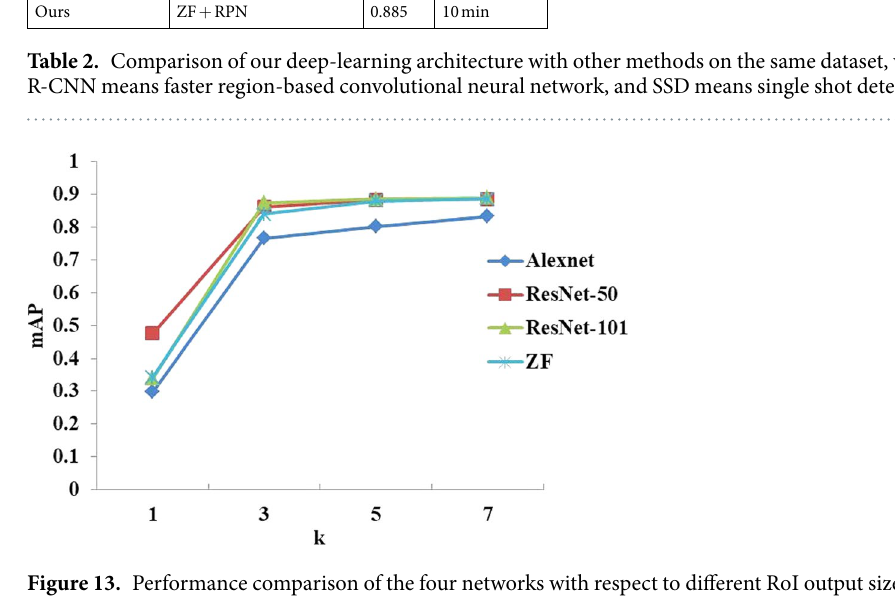
Figure 13. Performance comparison of the four networks with respect to different RoI output sizes.